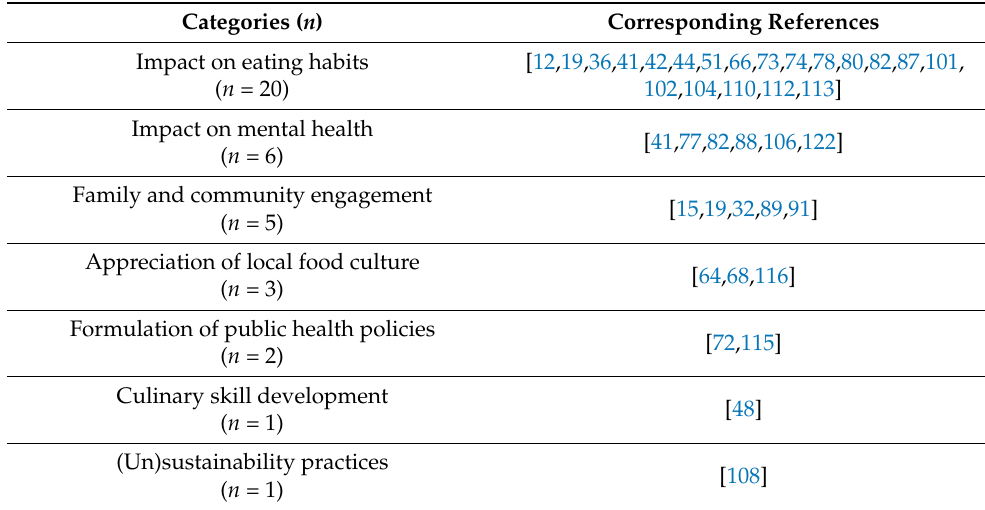
Table 3. Categories identified in studies on emerging health topics related to digital forms of com-